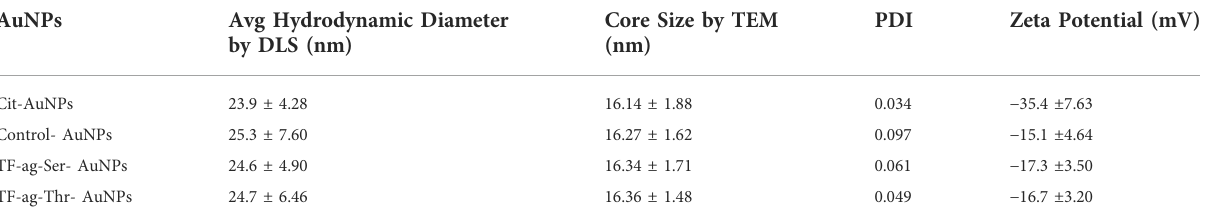
TABLE 1 Physical properties of materials prepared in this work. AuNPs Avg Hydrodynamic Diameter by DLS